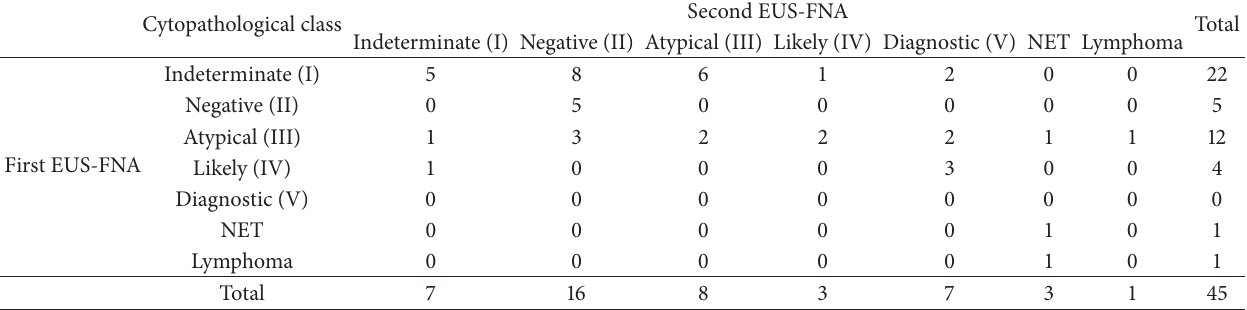
Comparison of first and second EUS-FNA results in patients with suspected pancreatic cancer. Divided by cytopathological diagnosis (EUS-FNA: endoscopic ultrasound fine-needle aspiration; NET: neuroendocrine